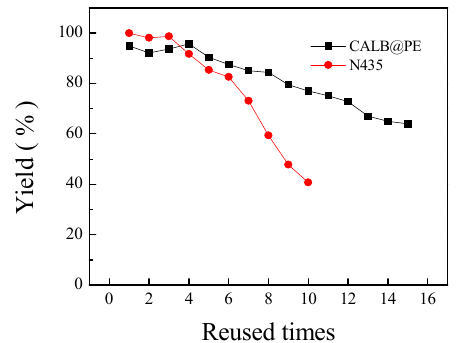
Figure 6. Reusability of CALB@PE and Novozym 435 (N435) in biodiesel production.